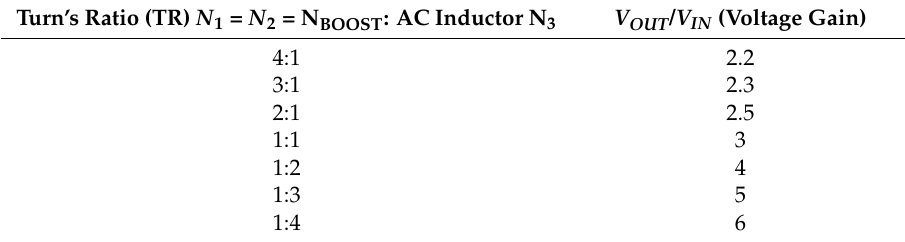
Table 1. Dependency of voltage gain on the inductance